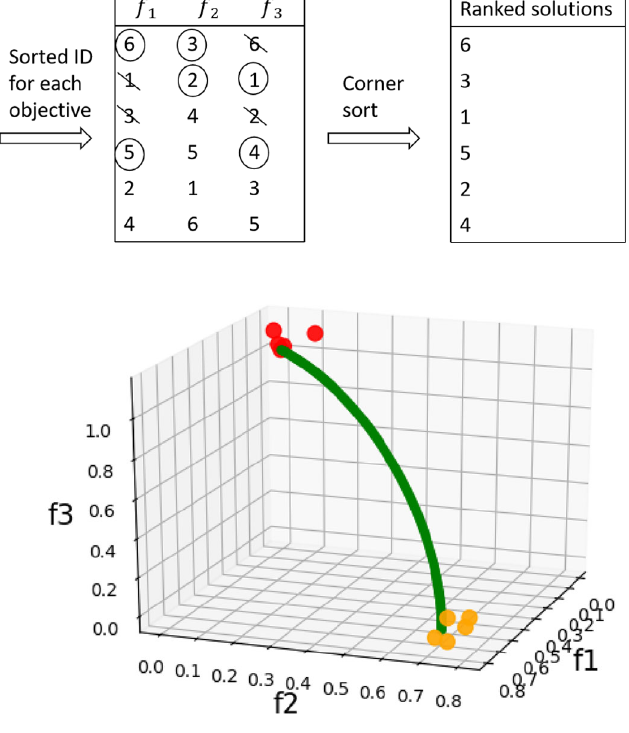
Fig. 4 Reducing the number of corners using Silhouette